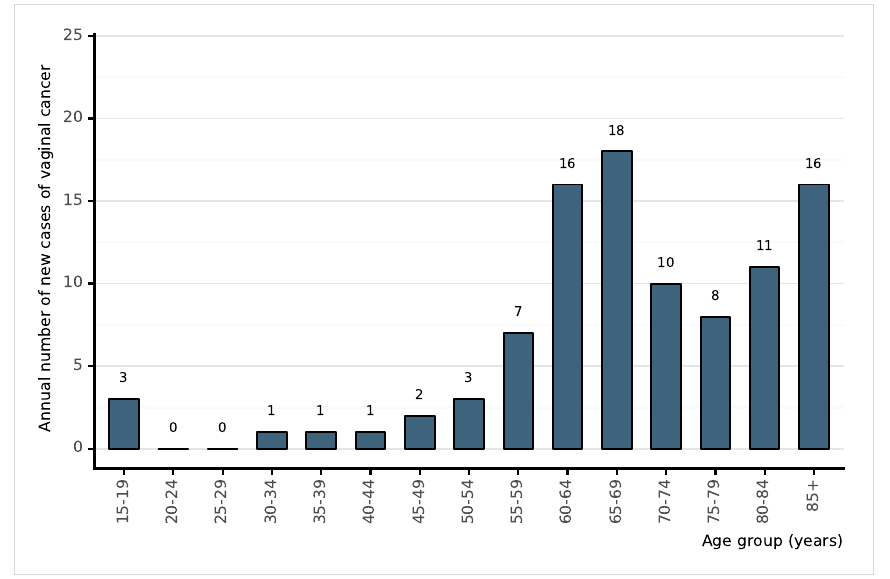
Figure 27: Annual number of new cases of vaginal cancer in Peru (estimates for